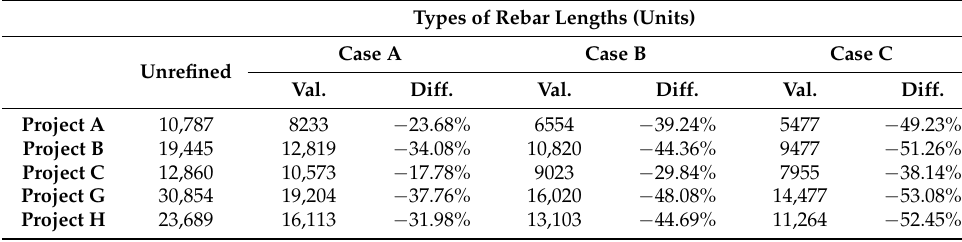
Table 8. Numbers of LPRS for Slab Members and Differentials by Cases.